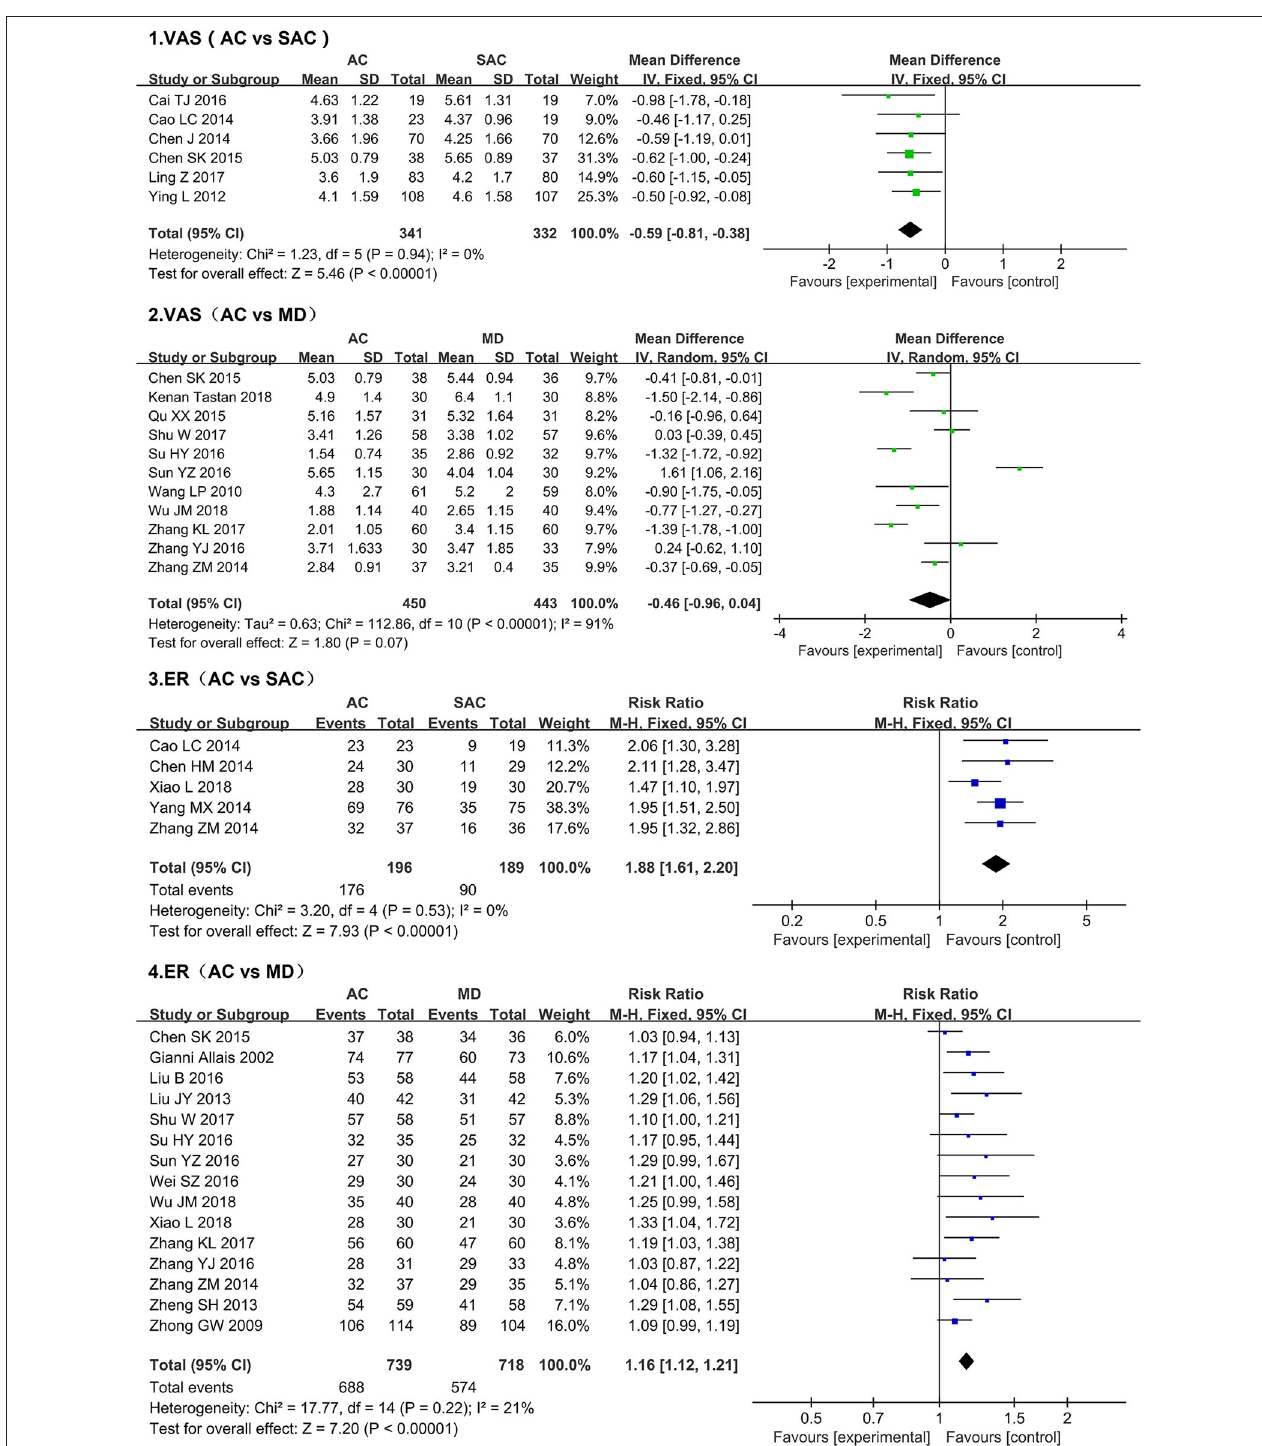
FIGURE 5 | Forest plots of the visual analog scale score and effective rate after treatment.